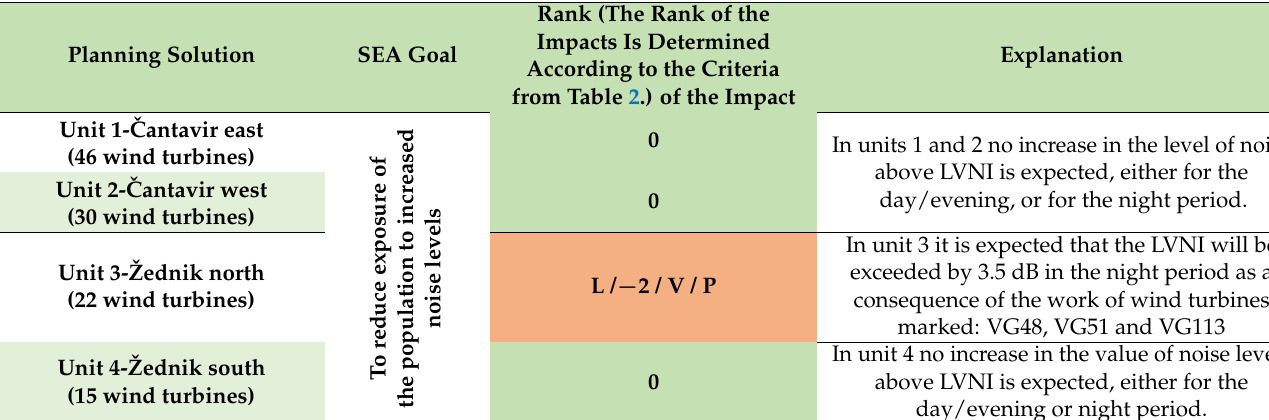
Table 5. Excerpt from the table “SEA objectives and indicators” related to noise. (Source: SEA for the Urban Plan of the Maestrale Ring wind farm).